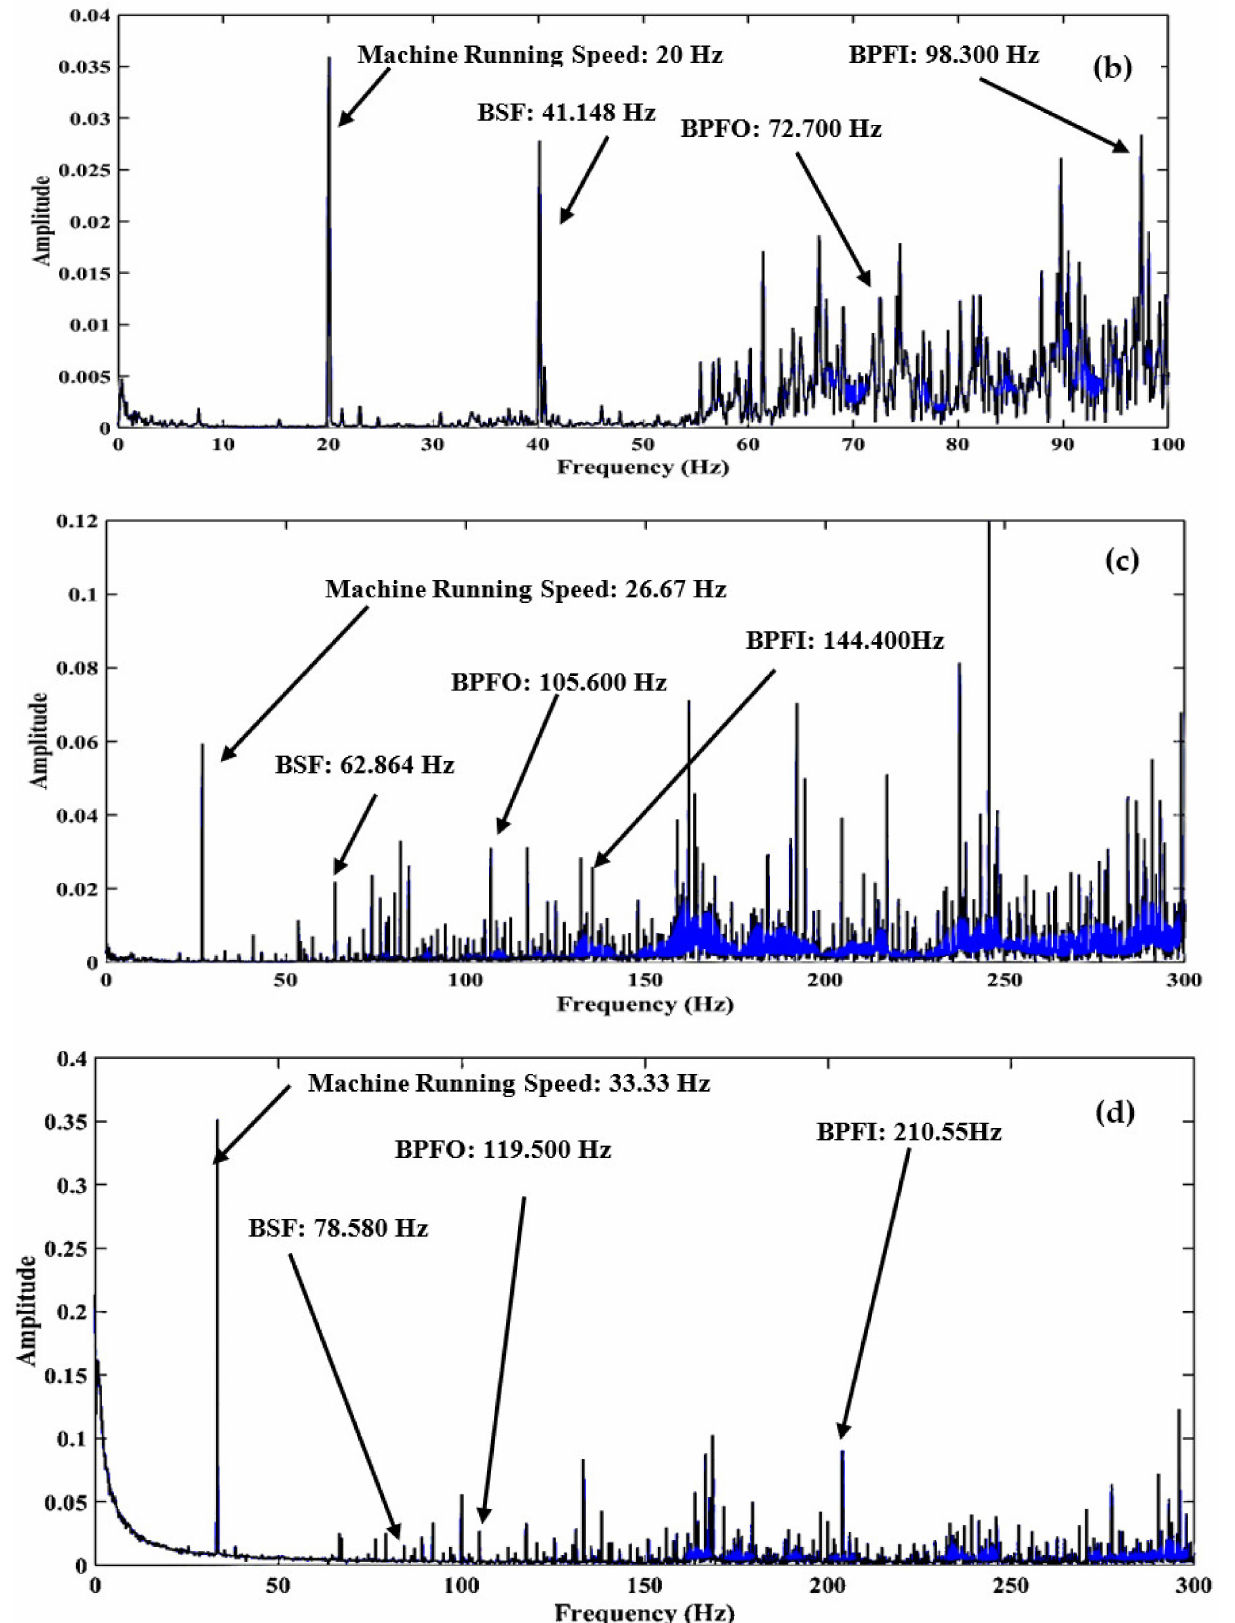
Figure 9. ( a – d ) FFT plot at ( a ) 800 rpm, ( b ) 1400 rpm, ( c ) 1800 rpm, and ( d ) 2200